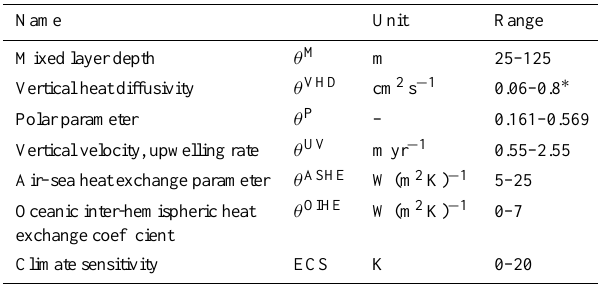
Table A1. Priors of ECS and the other model parameters θ